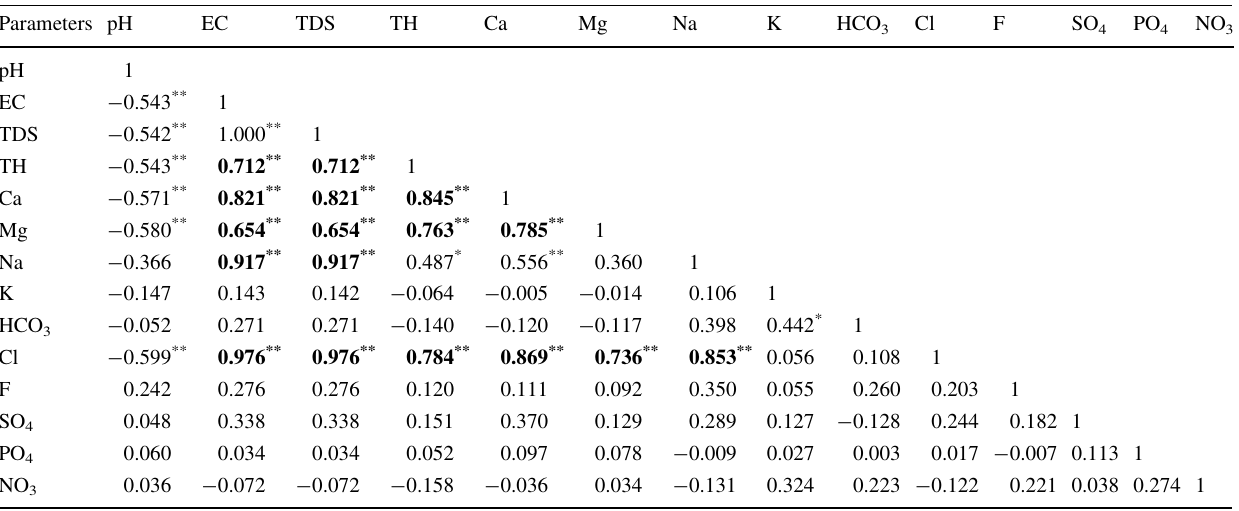
Table 4 Correlation coefficient matrix of major cations and anions of the study area—May 2013 Parameters pH